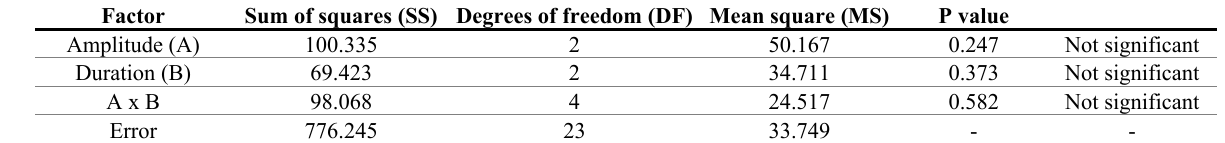
Table 4. Two-way ANOVA of compressive strength results. Factor Sum of squares (SS) Degrees of freedom (DF) Mean square